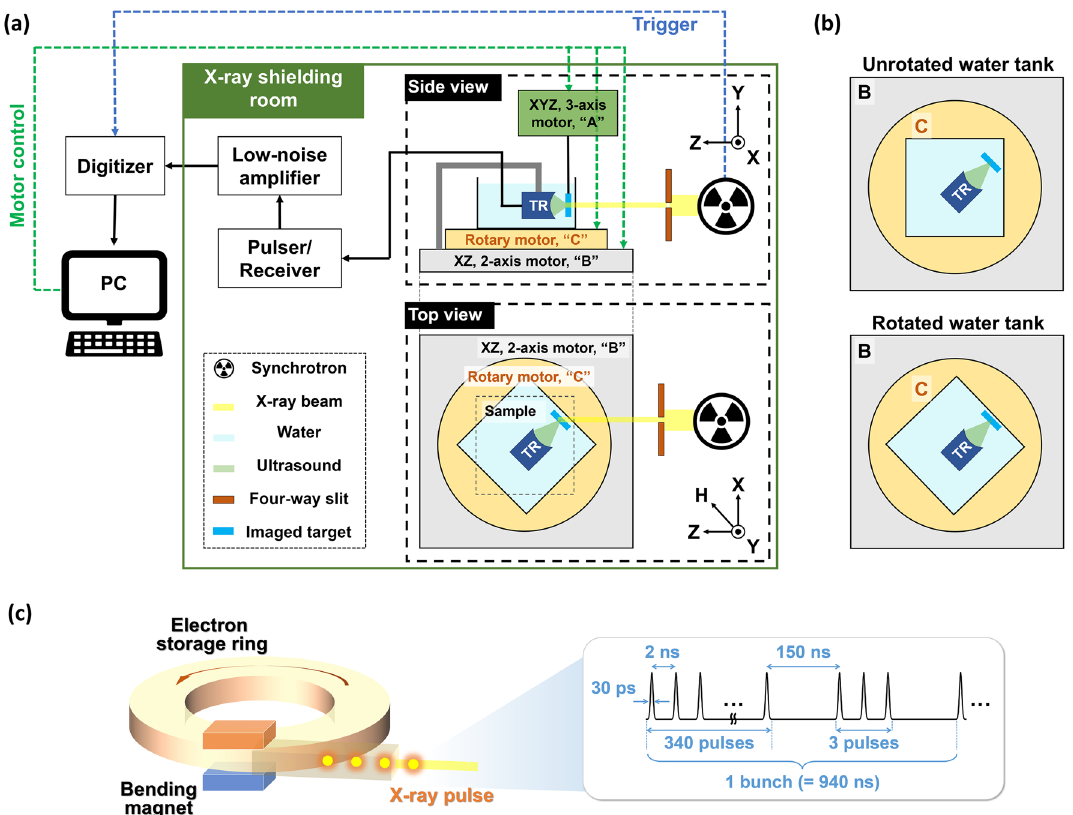
Figure 1. ( a ) Schematic of a synchrotron X-ray induced acoustic imaging system. ( b ) Alignment of an imaging target, ultrasound transducer, and water tank. ( c ) Schematic of the X-ray synchrotron and the X-ray pulse sequence; TR,